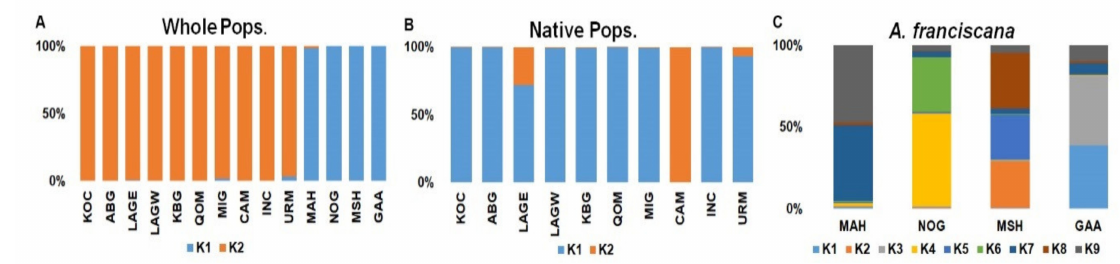
Figure 7. Proportion of genetic clusters for each locality in the STRUCTURE analysis ( A = whole examined populations, B = native populations, C = invasive A. franciscana; abbreviations listed in Table 1).